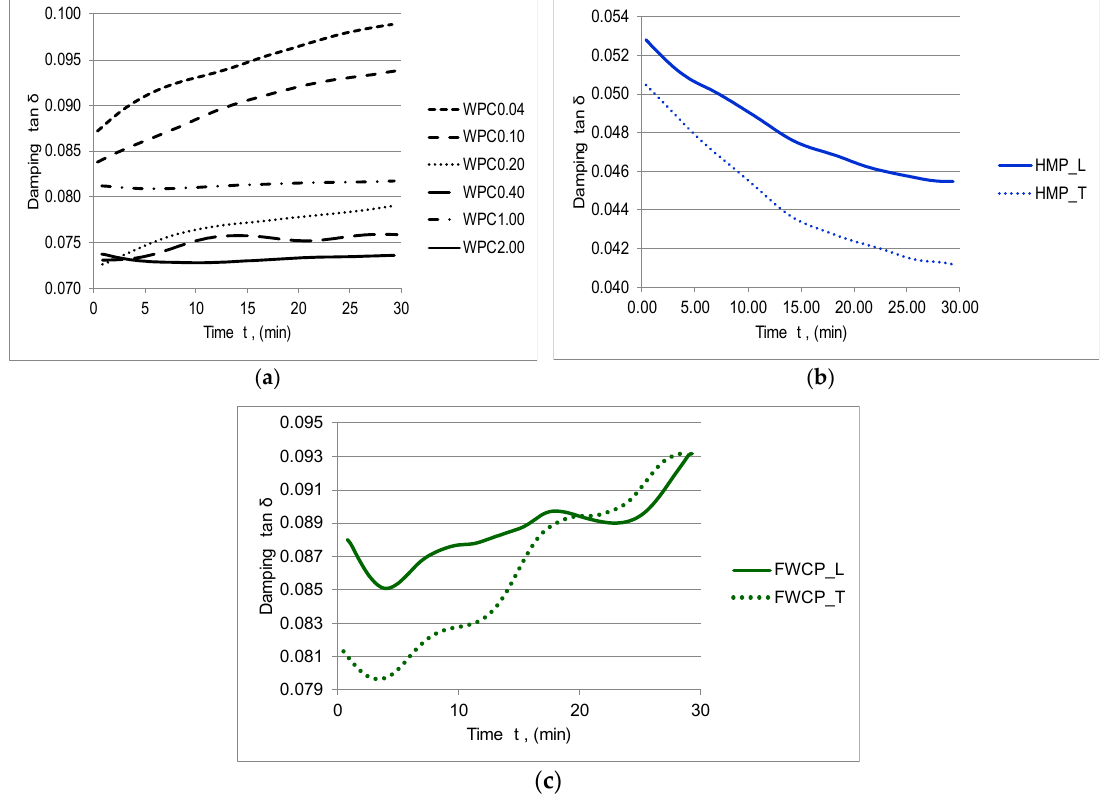
Figure 11. Variation of the damping tan δ in time: ( a ) WPC samples; ( b ) HMP samples; ( c ) FWCP samples.